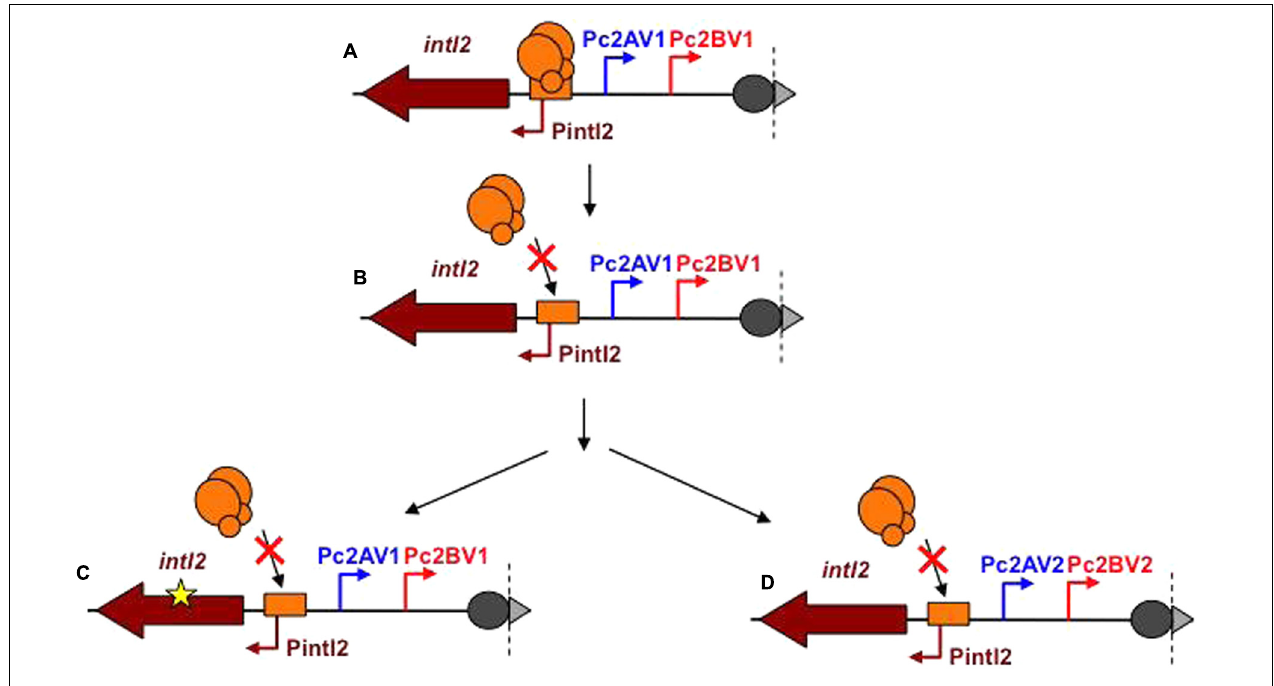
FIGURE 6 | Model of evolution of intI and Pc promoters in class 2 integrons. (A) Ancestral class 2 integron. The intI2 gene encodes a functional IntI2 integrase. LexA binds its operator and represses the expression of intI2 . The Pc2 promoters are the V1 versions (high level of cassette gene expression). (B) Evolution of the LexA operator preventing LexA binding leading to derepression of intI2 expression. Constitutive expression of intI2 increases the fitness cost of the class 2 integron. This higher fitness cost is counterbalanced through mutations (C) , introducing of a premature STOP codon in the IntI2 coding sequence, releasing the fitness cost, and giving raise to the prevailing current class 2 integrons; (D) weakening the Pc2 promoters (Pc2AV2 and Pc2BV2) but keeping an active integrase, this evolution pathway being